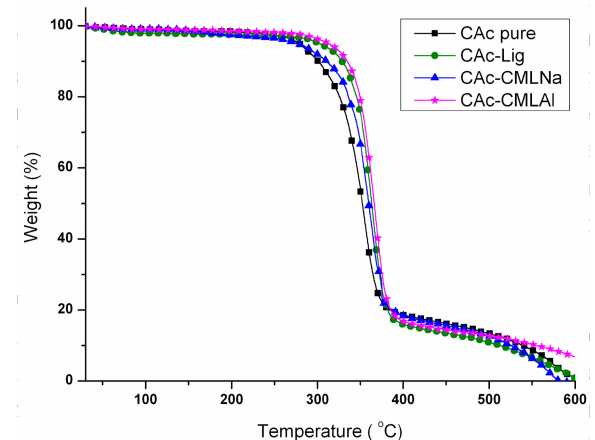
Figure 5. Thermogravimetry (TG) curves for the membranes of group I.